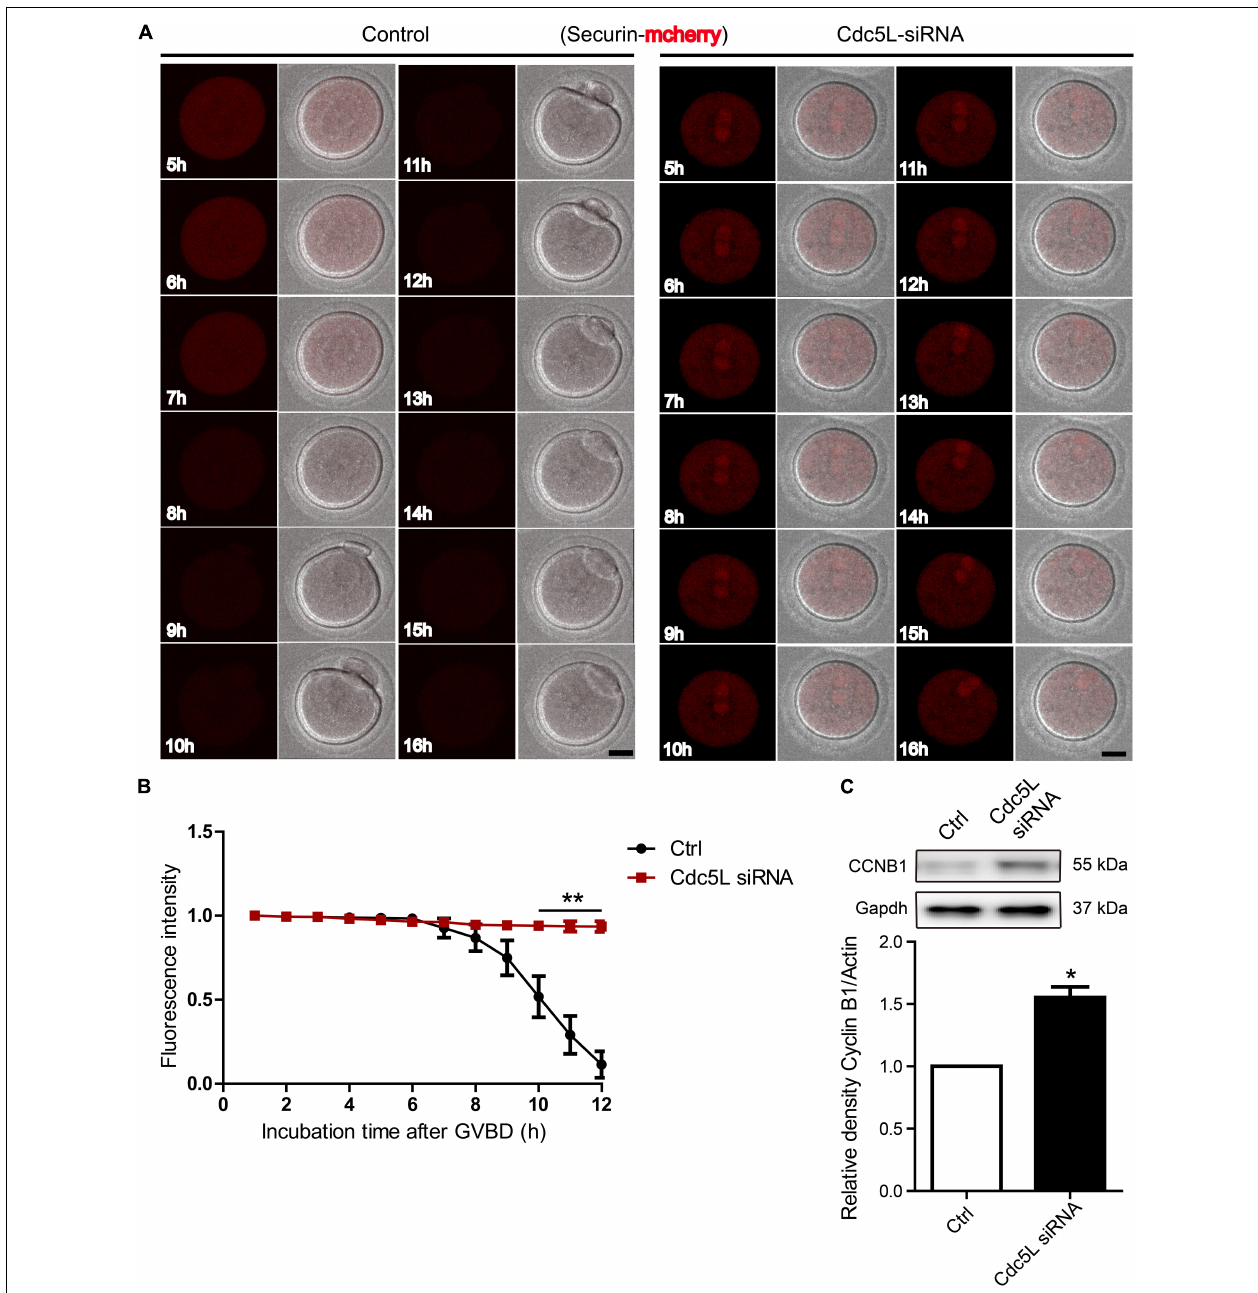
FIGURE 4 | Knockdown of Cdc5L induces insufficient APC/C activity. (A) Representative time-lapse confocal images for mCherry-securin in control ( n = 20) and Cdc5L knockdown ( n = 15) oocytes. Concentration of separase sensor mRNA used was 200 ng/ µ l. Scale bars: 20 µ m. (B) Analysis of mCherry-securin fluorescence intensity in control and Cdc5L knockdown oocytes. Data are shown as means ± SEM. “*” represents P < 0.05; “**” represents P < 0.01. Oocytes were analyzed for each group as follows: Ctrl, n = 20; Cdc5L siRNA, n = 15. (C) Expression of CCNB1 protein as revealed by Western blotting analysis. Oocytes were collected at 9.5 h after release from IBMX (150 oocytes per sample). At least three replications were conducted, and 450 oocytes were used for each group.